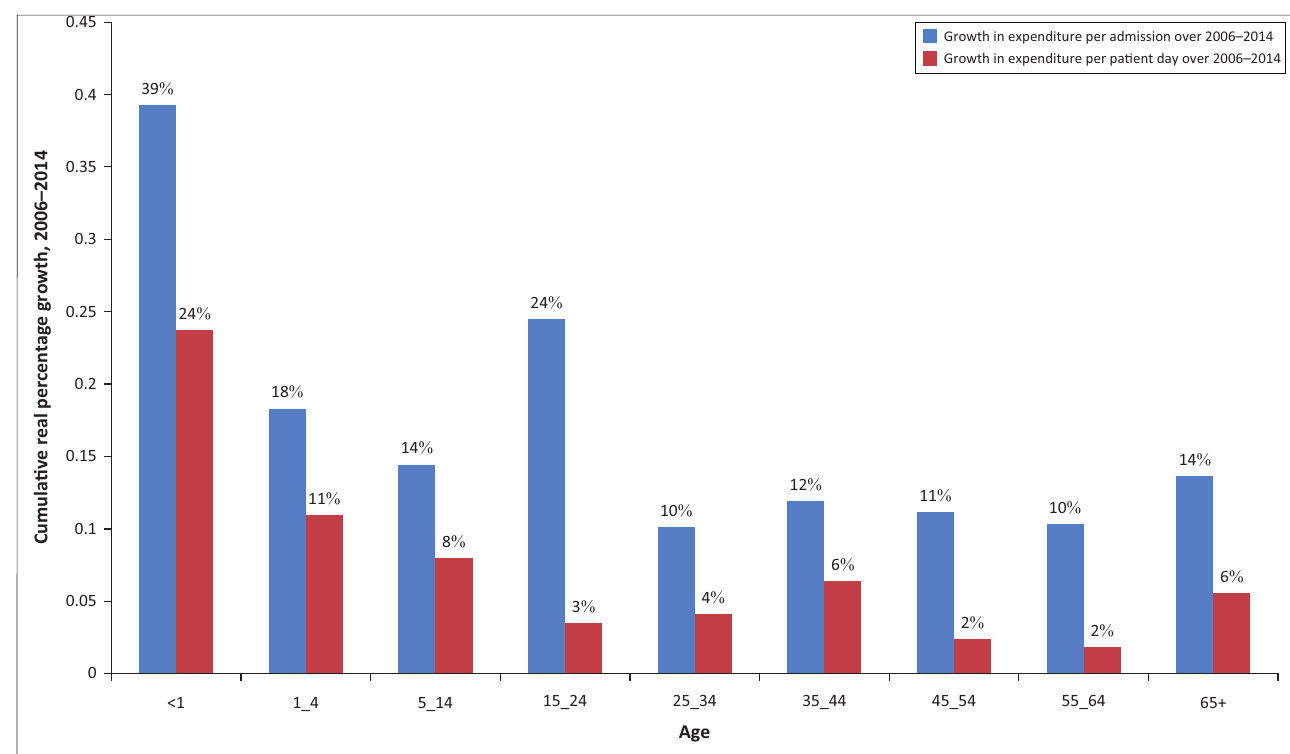
FIGURE 10: Cumulative real expenditure (Rands) growth per admission and patient day, per age group; for Netcare, Mediclinic and Life Healthcare; 2006 and